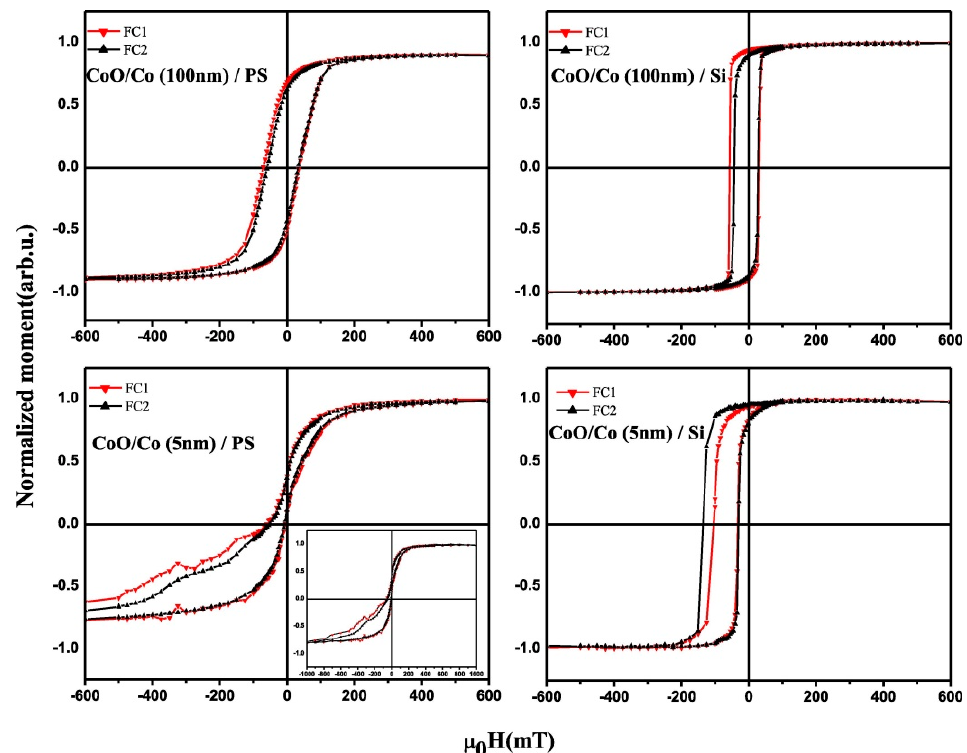
Figure 6. Measurements at T = 5 K (i.e., far below the blocking temperature near room temperature) on Co/CoO thin films (thickness 5 nm or 100 nm) on polystyrene (PS) nanospheres or plane Si substrates, respectively. Reprinted with permission from [79], Copyright 2020 Elsevier.